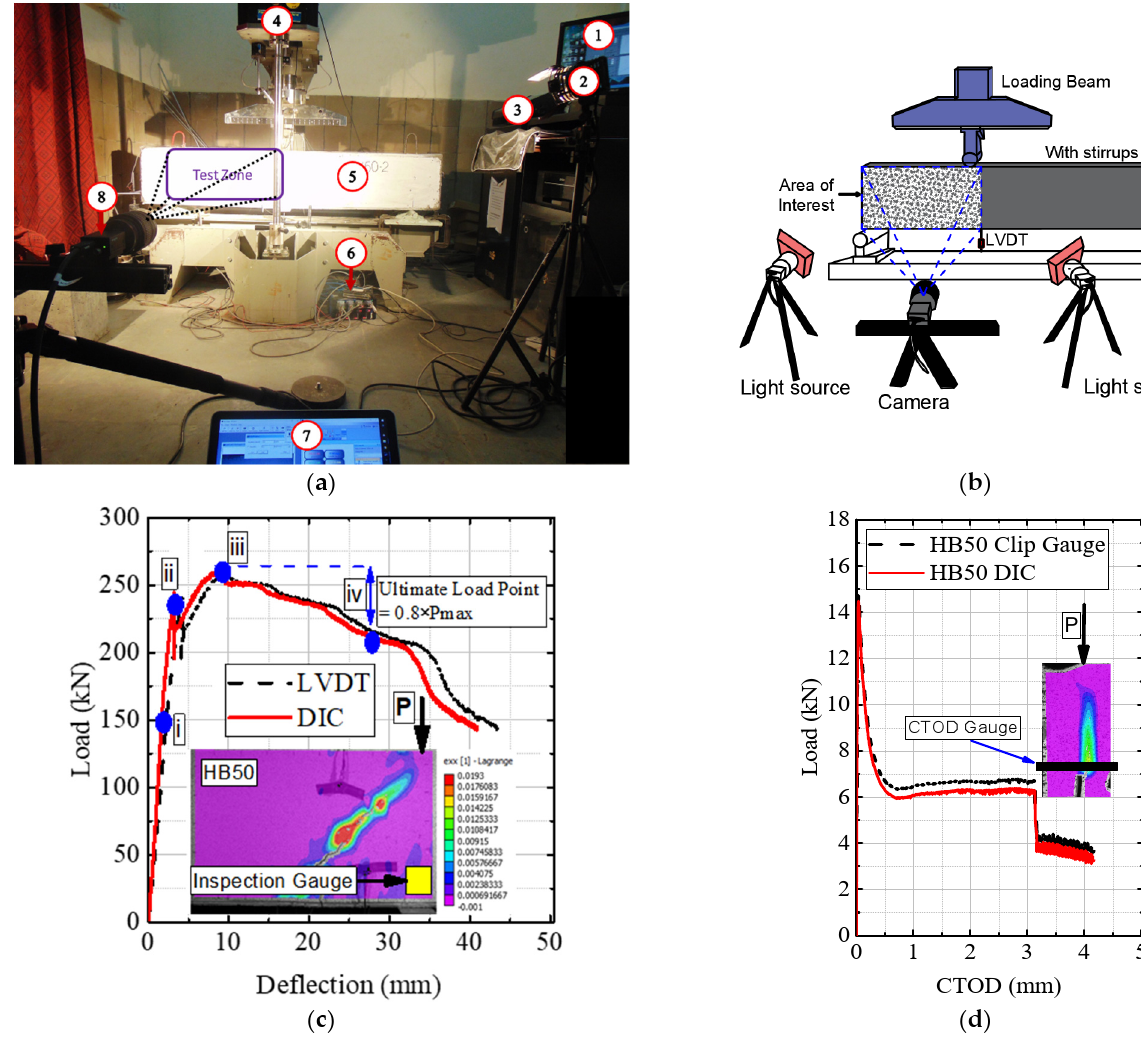
Figure 6. Experimental test setup for shear study: ( a ) Test setup. 1. Controller monitor. 2. The light source. 3. Controller. 4. FTM frame of 300 kN capacity. 5. Test specimen. 6. Data Acquisition system (DAQ). 7. DAQ storage. 8. Digital image correlation camera. ( b ) Schematic view of instrumentation